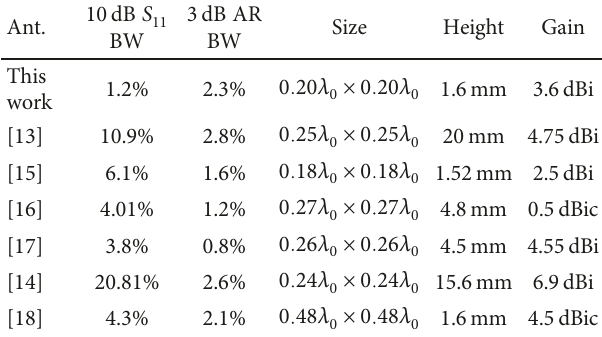
Table 1: Comparison of conventional single-feed circularly polarized